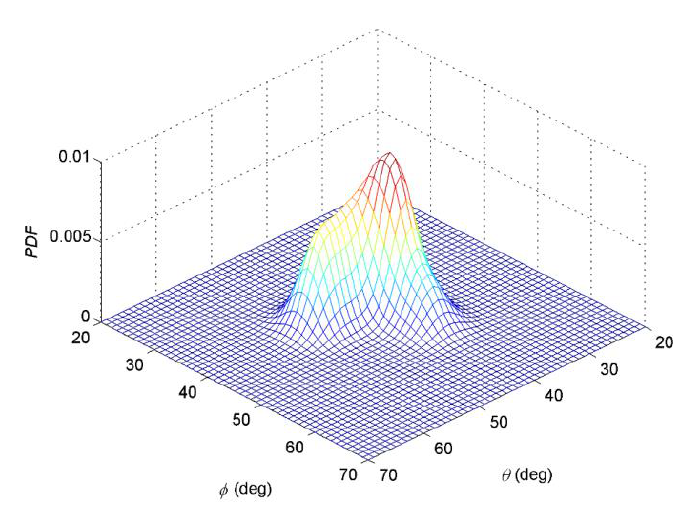
Figure 5. The estimation of non-symmetric APDF by the proposed method.